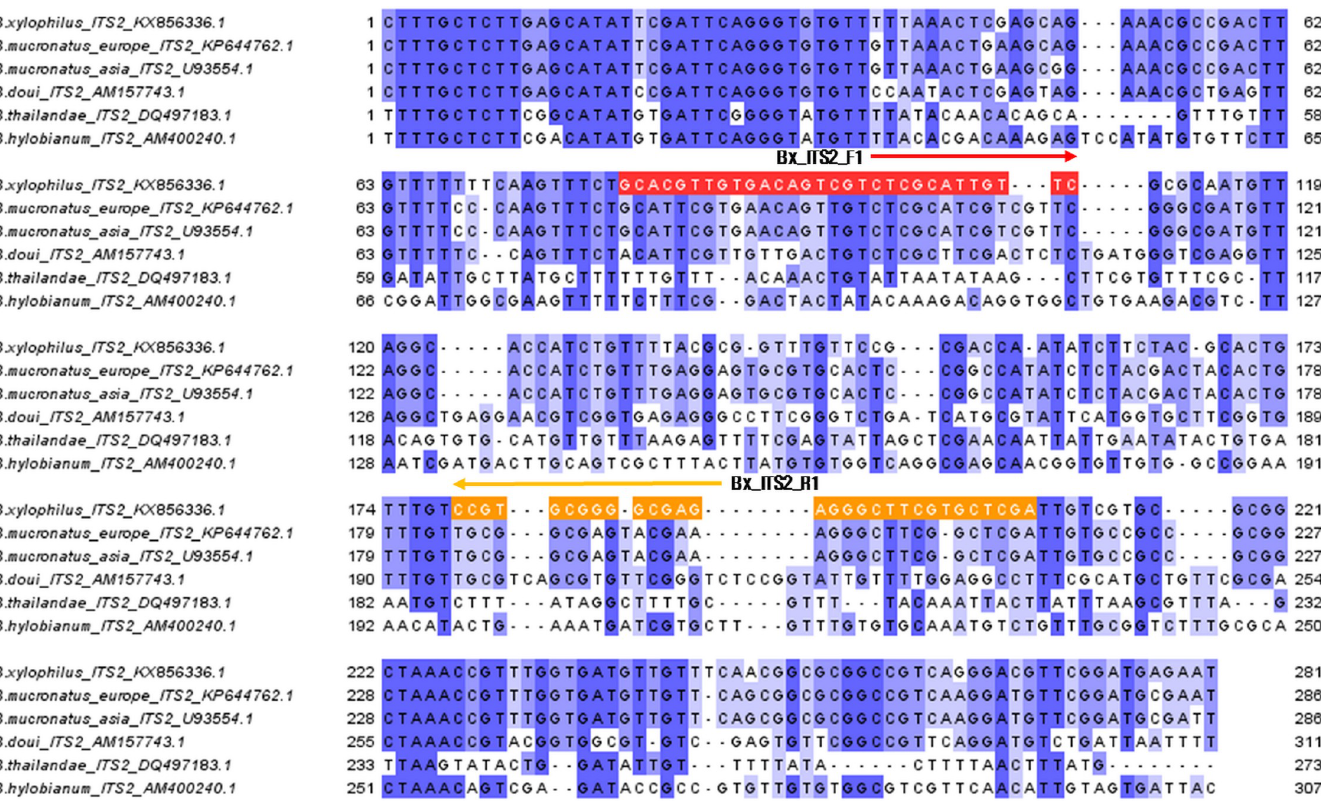
Fig 1. Nucleotide sequence alignment of the internal transcribed spacer 2 (ITS2) from B . xylophilus ( Bx ), B . mucronatus Europe type ( BmE ), B . mucronatus Asia type ( BmA ), B . doui ( Bd ), B . thailandae ( Bt ), and B . hylobianum ( Bh ). Locations of the Bx_ITS2_F1 and Bx_ITS2_R1 primers are marked with a red- and orange- colored box, respectively. Gaps in the sequence alignment are indicated with dots. Sequence identity is indicated with blue-colored gradation.